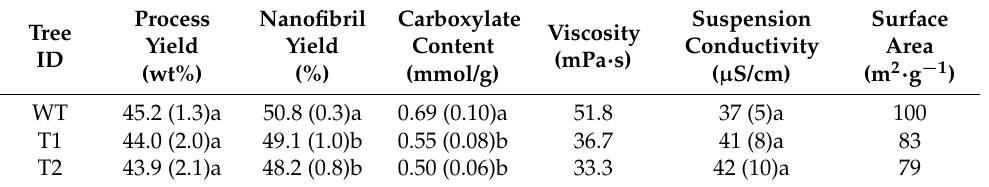
Table 1. Fibrillation metrics for CNFs isolated from WT, T1, and T2 with process yield, nanofibril yield, carboxylate content, viscosity (0.30 wt%), suspension conductivity (0.30 wt%), and surface area estimates of CNFs in suspension. Values in brackets indicate standard deviations.